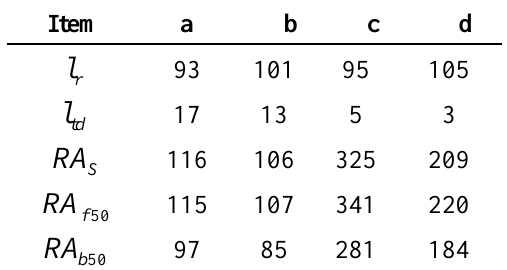
Table 4. The terrain drop measurement results corresponding to case-3.